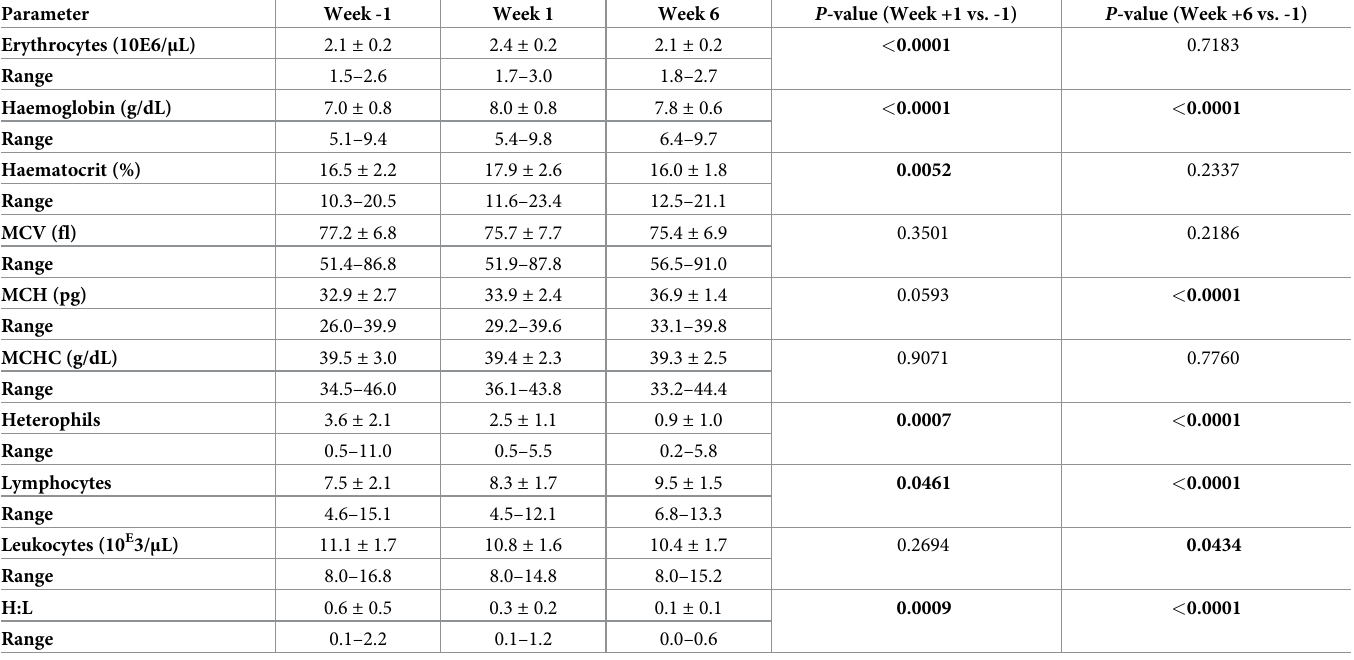
Table 5. Means ( ± standard deviations) and ranges of complete blood count parameters before and after acaricidal medication with fluralaner administrations in weeks 0 and 1.